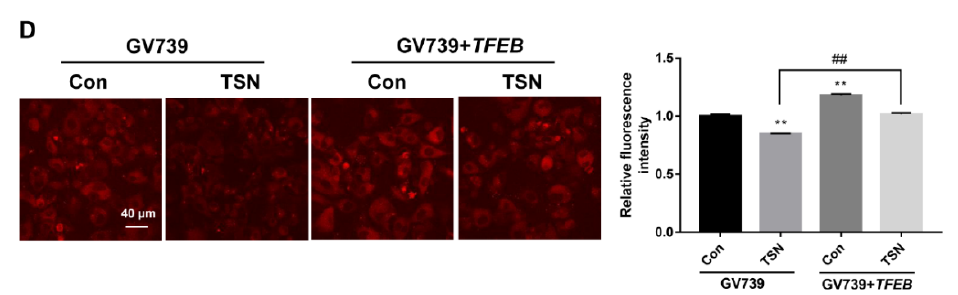
Figure 5. TSN blocked autophagic flux by inhibiting TFEB in vitro. ( A ) HepG2 cells and L02 cells treated with TSN for 6 h at different concentrations (2.5, 5 10, 20 µ M) were analyzed by Western blotting for the protein levels of TFEB and p-TFEB (Ser211). ( B ) HepG2 cells and L02 cells were treated with TSN for 6 h at different concentrations (2.5, 5 10, 20 µ M). The expression levels of TFEB in nuclear and cytosolic fractions were determined using Western blotting. ( C , D ) HepG2 cells were transfected with GV739 plasmid or TFEB -GV739 plasmid and then were treated by TSN (10 µ M) for 6 h. The protein levels of TFEB, LC3B, P62, and CTSB were determined by Western blotting ( C ). Lysosomal acidity was monitored by LTR staining, and the relative LTR fluorescent intensity was quantified ( D ). Scale bar: 40 µ m. Data are presented as the mean ± SD of three independent experiments. Relative protein expression levels were calculated using ImageJ software. * p < 0.05, ** p < 0.01 versus vehicle control. ns, not significant. # p < 0.05, ## p < 0.01 versus TSN group in cells transfected with empty plasmid GV739.